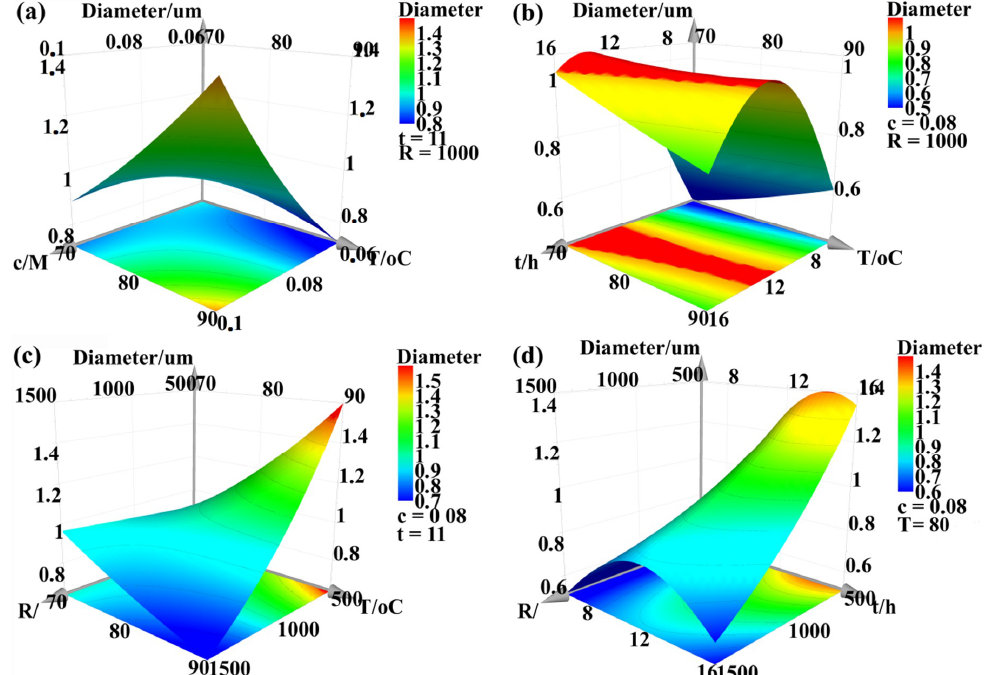
Figure 4. The response surface plots of the diameters with varied parameters while the other two parameters were fixed: ( a ) varied the concentration of Zn 2 + (c) and reaction temperature (T), while reaction time ( t ) = 11h and the molar ratio of Zn 2 + to tri-sodium citrate (R) = 1000; ( b ) varied t and T while c = 0.08 M and R = 1000; ( c ) varied R and T while c = 0.08 M and t = 11 h; and ( d ) varied R and t, while c = 0.08 M and T = 80 ◦ C.